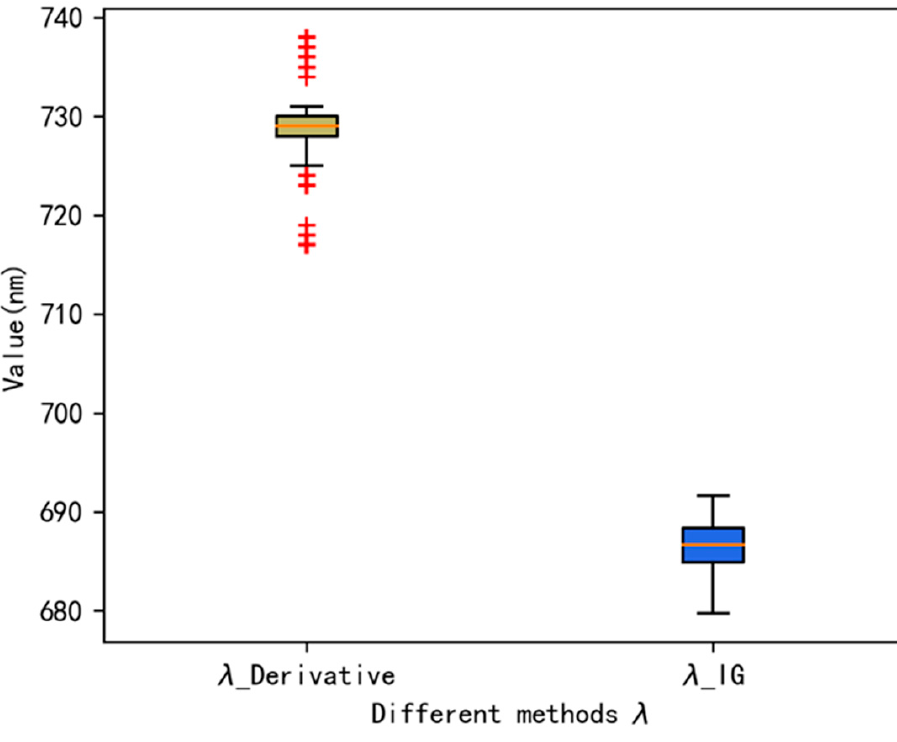
Figure 2. Box plots of the estimated λ 0 .